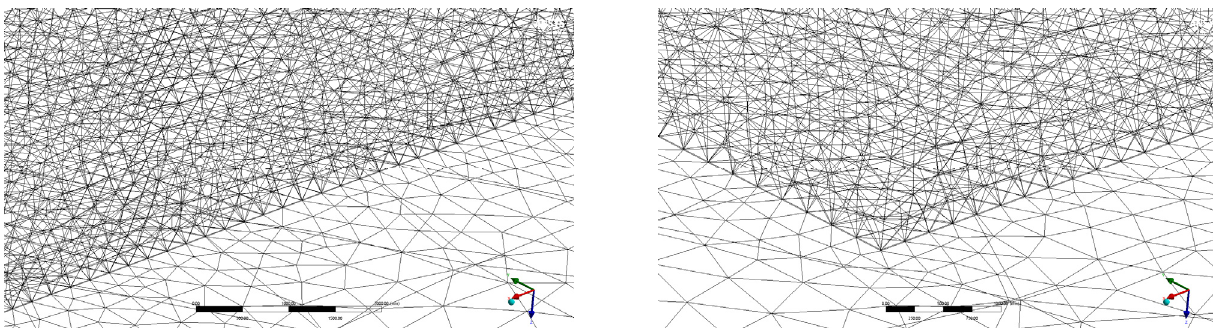
Figure 4. Detail of grid division node connections.